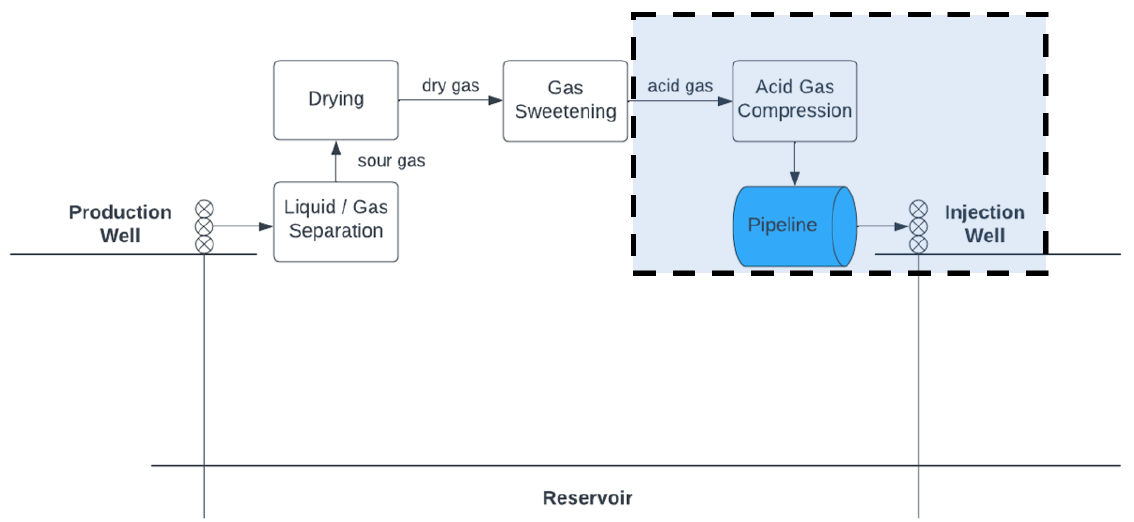
Figure 1. Acid gas treatment and reinjection